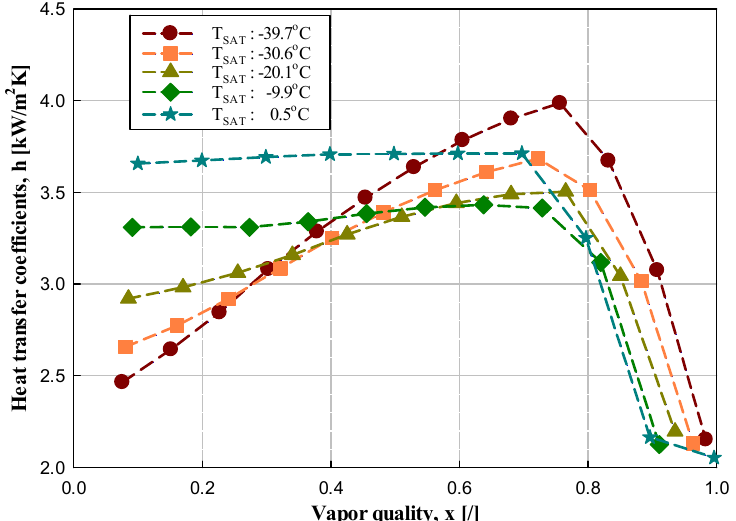
Figure 8. Variation in heat transfer coefficients according to various saturation temperatures at constant heat and mass fluxes (G: 200 kg/(m 2 ·s) and q: 20 kW/m 2 ).